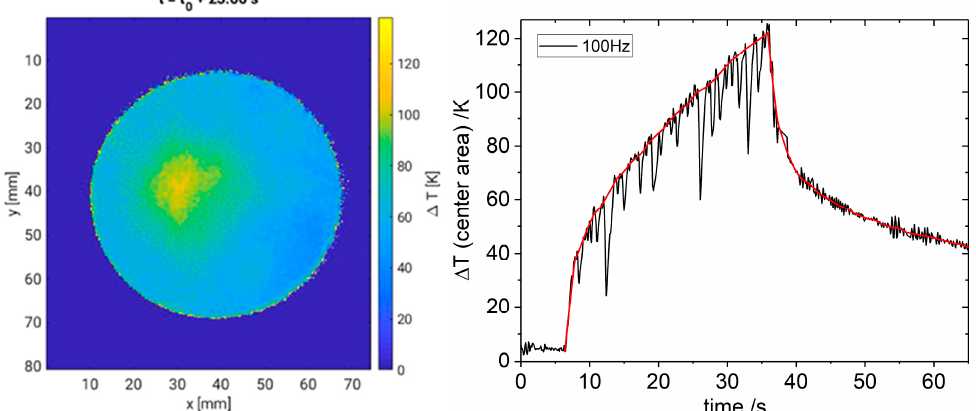
Figure 8. Evolution of temperature of a 3% at. Yb:YAG disk amplifier, pumped with B = 0.8 MW/cm 2 /sr at f = 100 Hz and τ p = 1 ms, in a cryogenically (LN 2 ) face-cooled configuration. Left: Temperature as function of position (false color, linearly scaled) for the Yb:YAG disk 25 s after measurements started (20 s after pumping begins). Right: Peak temperature increase over reference (LN 2 ) plane as function of time for pump pulses with f = 100 Hz (red curve: with measurement artefacts removed).